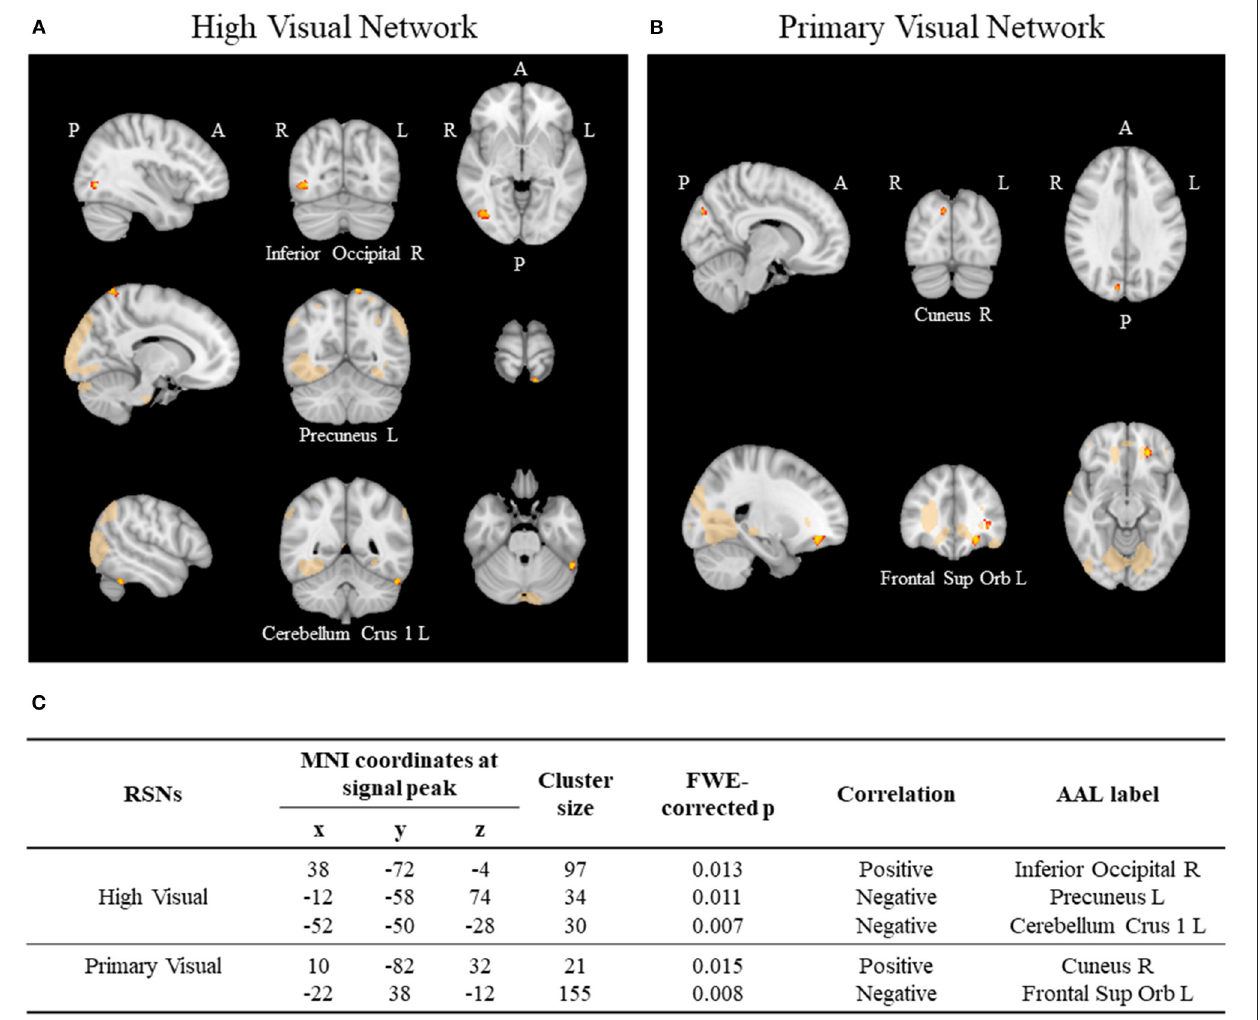
FIGURE 1 | Resting state networks (RSNs) using ICA. (A) Significant correlations between suicidal ideation and functional connectivity with the high visual network and the (B) primary visual network. Significance threshold was set to p < 0.05 (FWE-R correction for multiple comparisons). (C) Table illustrating the clusters positively and negatively associated with suicidal ideation score in each